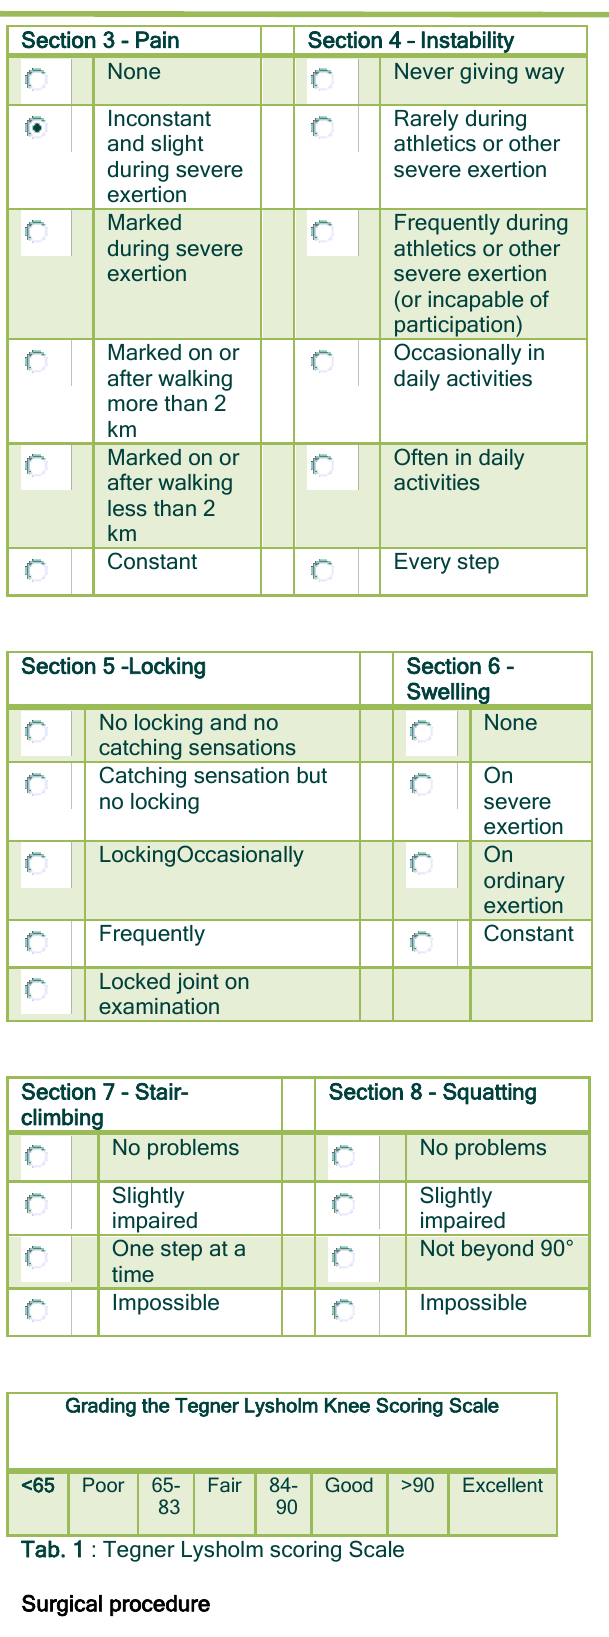
Fig. 6: Illustrating the systematic spiral pattern of microfracture penetrations of the subchondral bone plate throughout the cartilage lesion, allowing for a homogeneous distribution of the microfractures